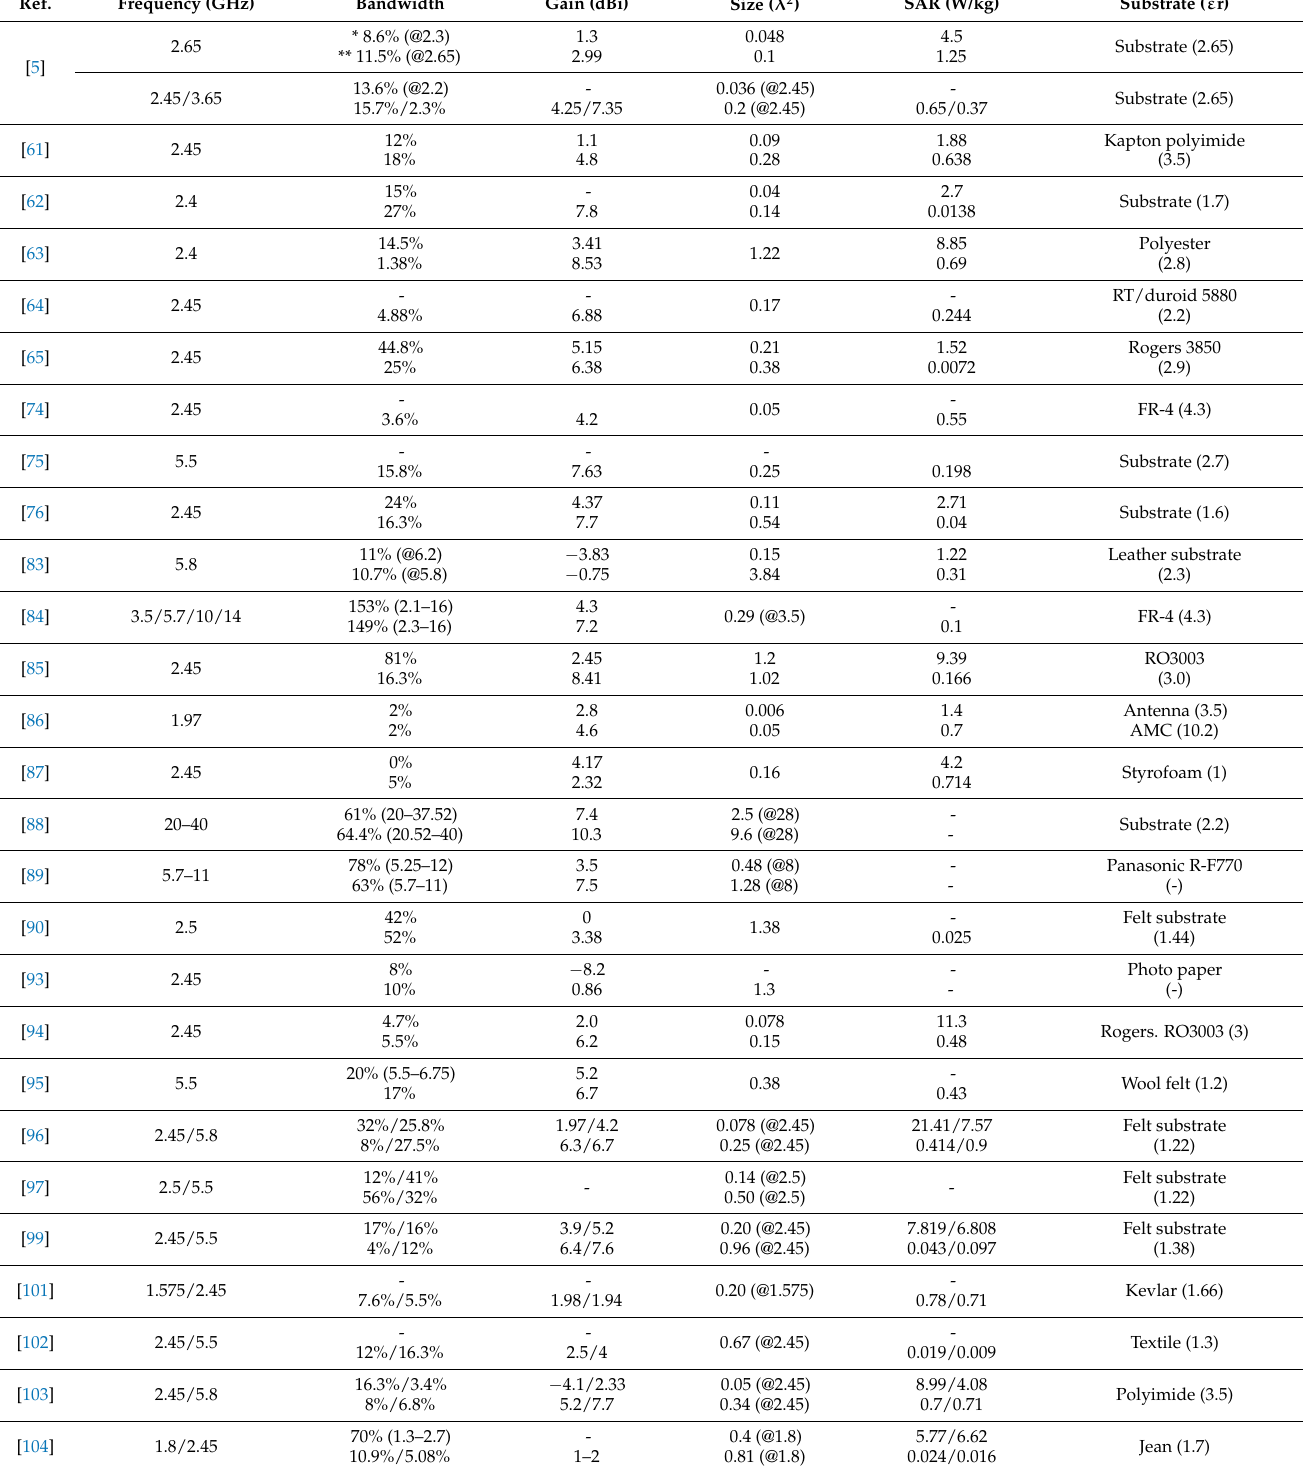
Table 2. Performances among the metasurface-based wearable